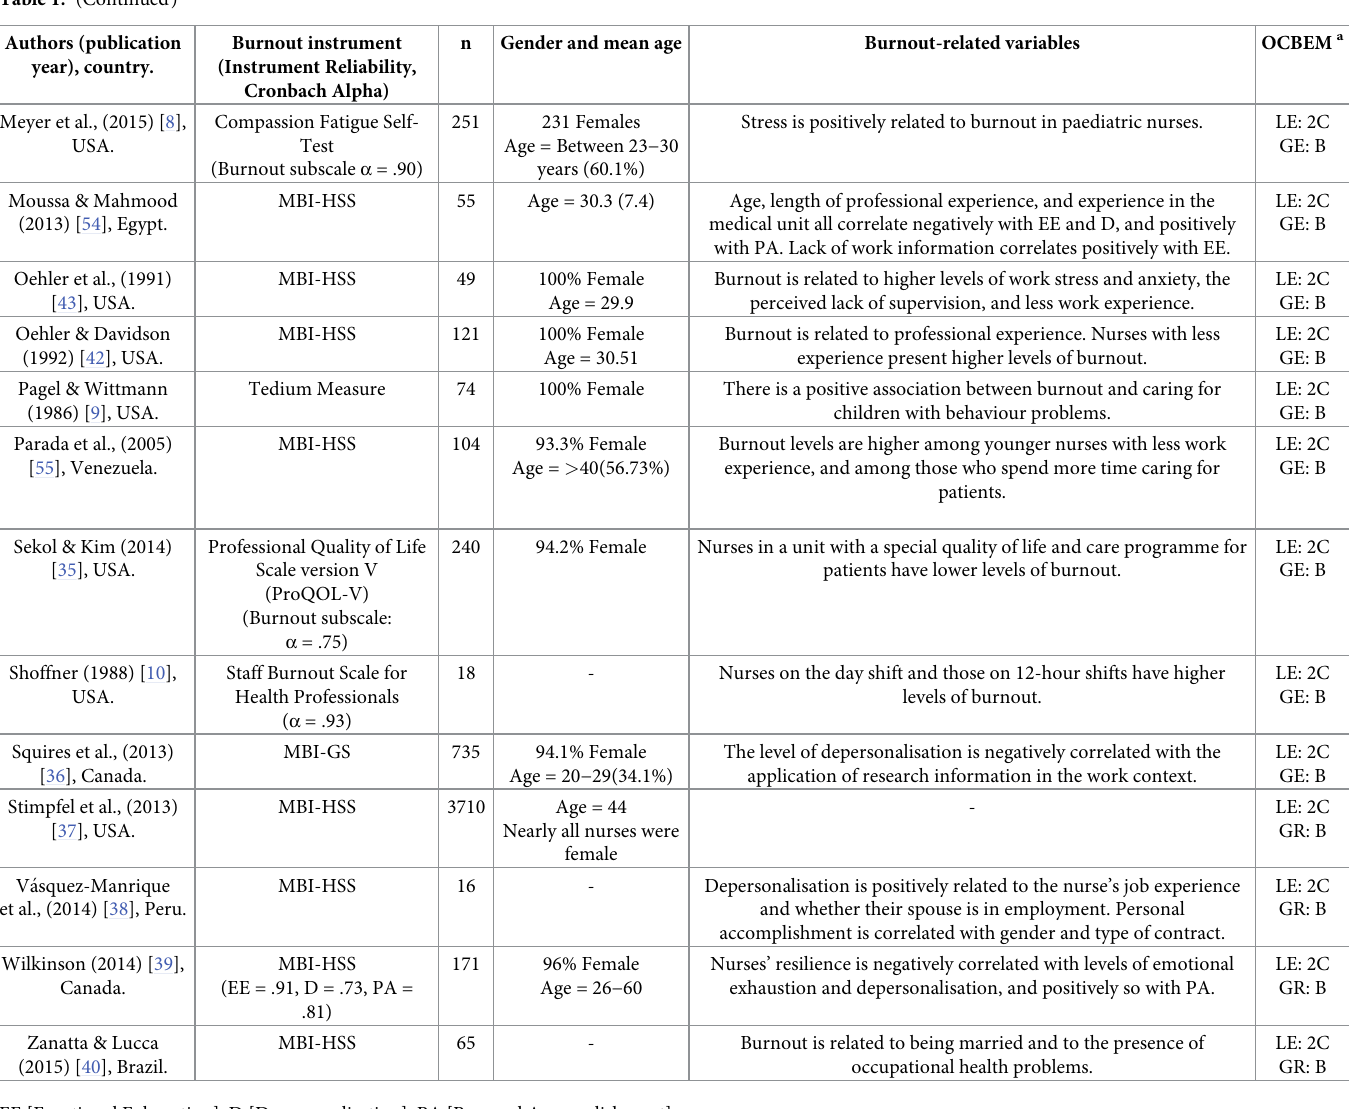
Sociodemographic factors : Few studies have analysed the relation between nurses’ age and marital status and burnout. According to the publications analysed, married status is associ- ated with lower levels of burnout [52], while age is inversely related to burnout levels, with younger nurses being more prone to this condition [2, 39, 52], although one study [34] reported a positive correlation between age and EE. Occupational factors : Various occupational factors are related to the development of burn- out syndrome. Some reports observe that high levels of job satisfaction are correlated with low burnout in paediatric nurses [52, 35]. A negative correlation has also been recorded between EE and job satisfaction